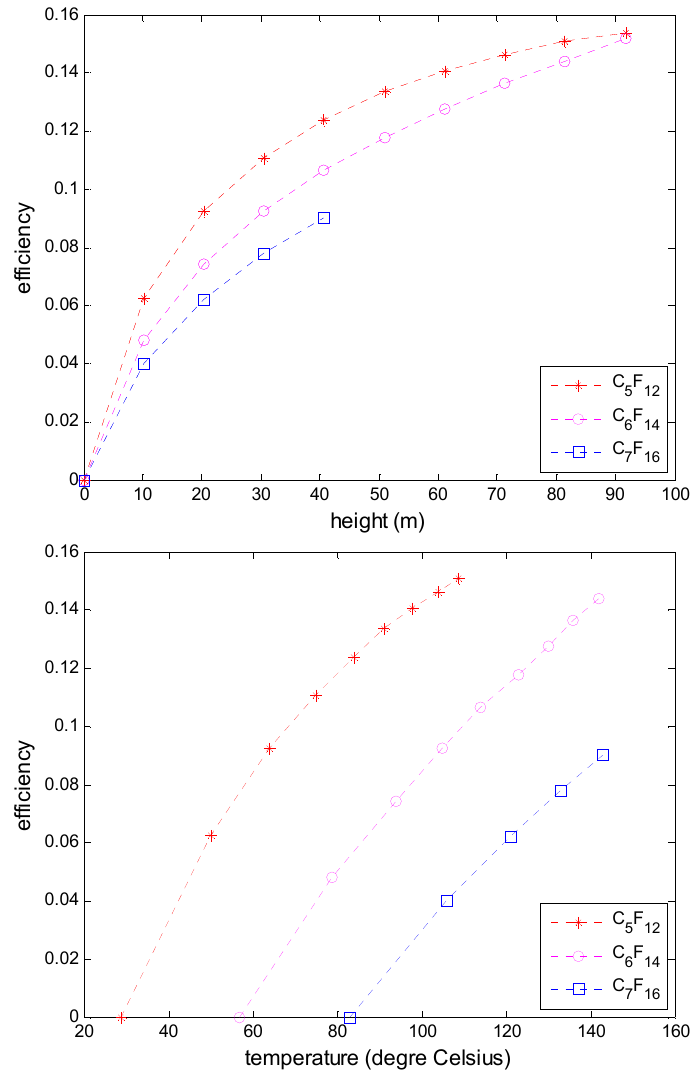
Figure 5. Theoretical efficiency vs. height ( top ) and efficiency vs hot source temperature ( bottom ). Numerical simulations have been carried out with CHEMCAD for three different working fluids (C 5 F 12 , C 6 F 14 , and C 7 F 16 ) following Equation (11) for a thermogravitational Rankine cycle with hot source temperatures and pressures up to 150 ◦ C and 10 bar, respectively. The cold source temperature is set at 20 ◦ C. The working fluid is kept in gas state during the rise and liquid state during the fall of the balloon, respectively. The efficiency is expressed relatively to 1 (i.e., not as a percentage).